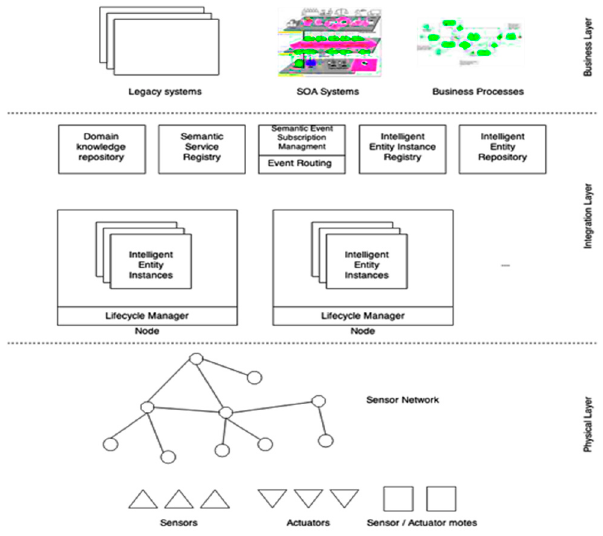
Figure 2. Generic ICE system interface and system model.